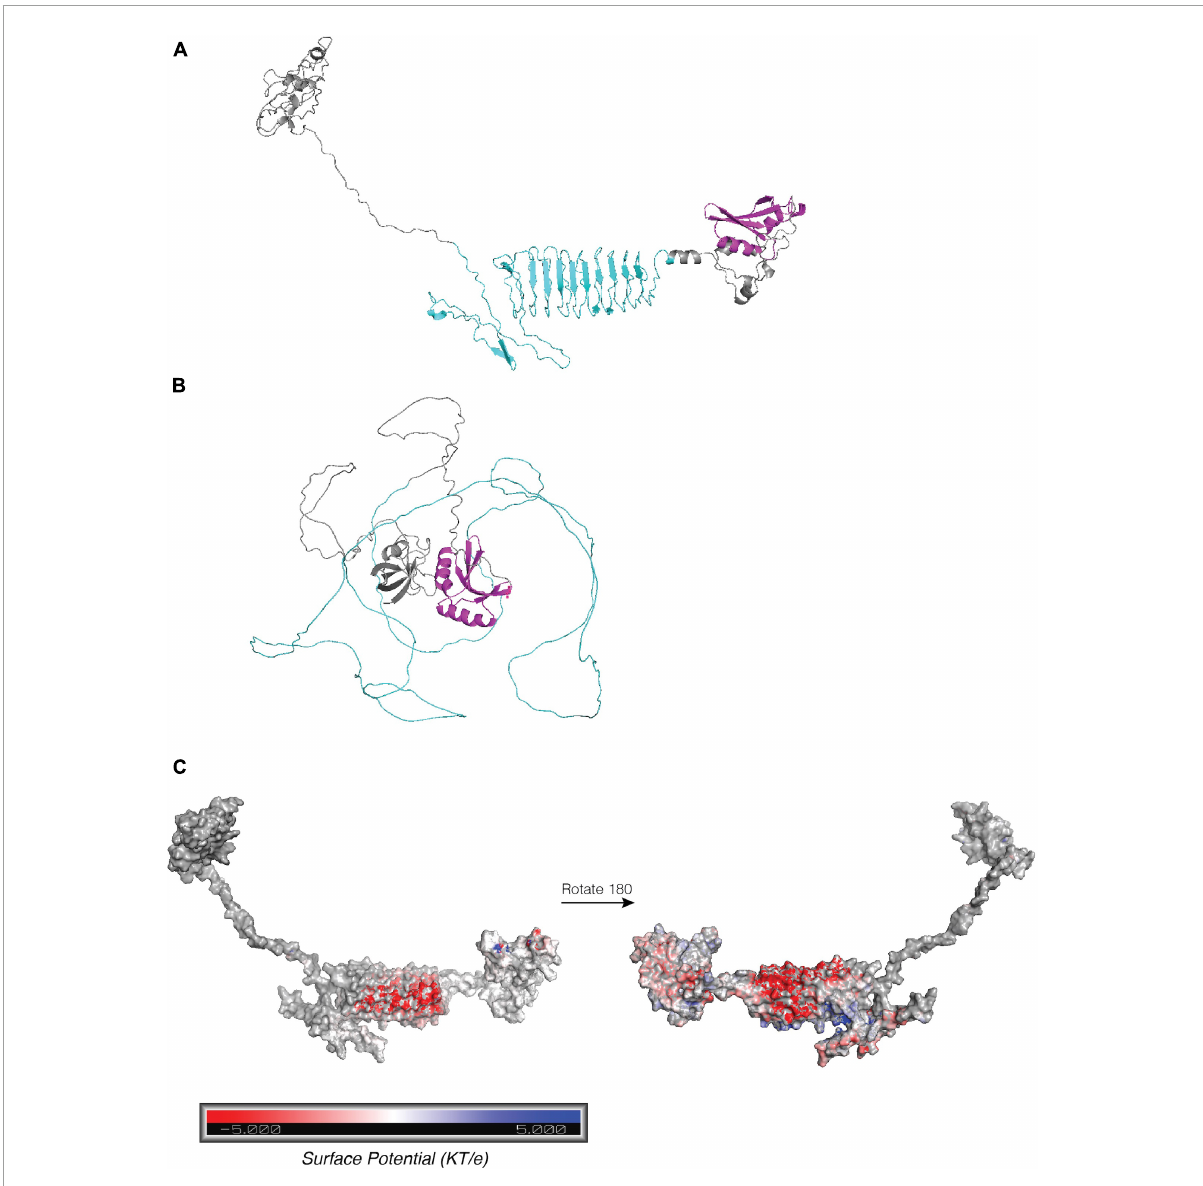
FIGURE5 Structure predictions ARP14A. (A) trRosetta and (B) AlphaFold predictions of structure of ARP14A. C-terminal SPOR domain is shown in magenta, repeats in cyan. (C) APBS electrostatic surface potential for trRosetta ARP structure from panel (A) . Red denotes negative charge (acidic) and blue denotes positive charge